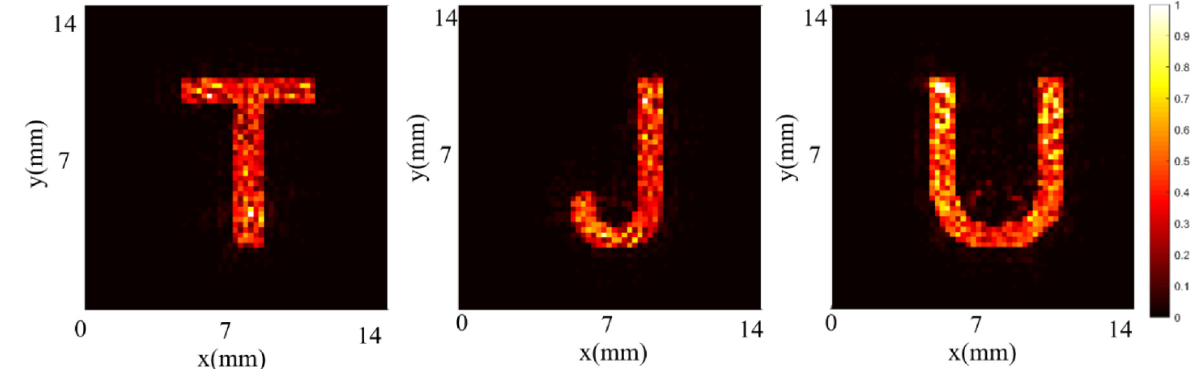
Fig. 8. Amplitude distribution diagram of the designed letters “ T ” , “ J ” and “ U ” at the